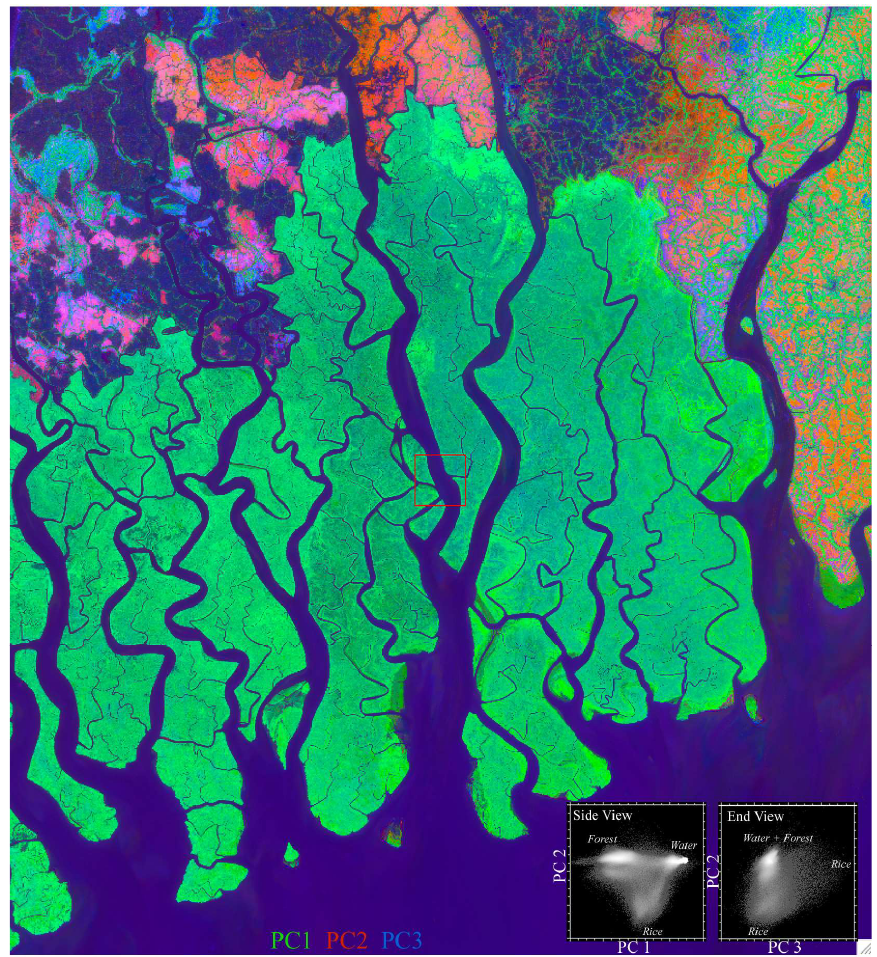
Figure 5. Low order PC composite of HLS S30 vegetation fraction time series. The inset temporal feature space shows clusters distinguishing mangrove forest from rice fields from water bodies. The wide variety of rice phenologies produces a 3D continuum encompassing more of the feature space than the forest-water continuum and compressing the forest into two closely packed clusters in one apex of the feature space. As a result, the forest appears only shades of green but the rice paddys appear a variety of colors corresponding to varying combinations of PCs 1, 2 & 3.